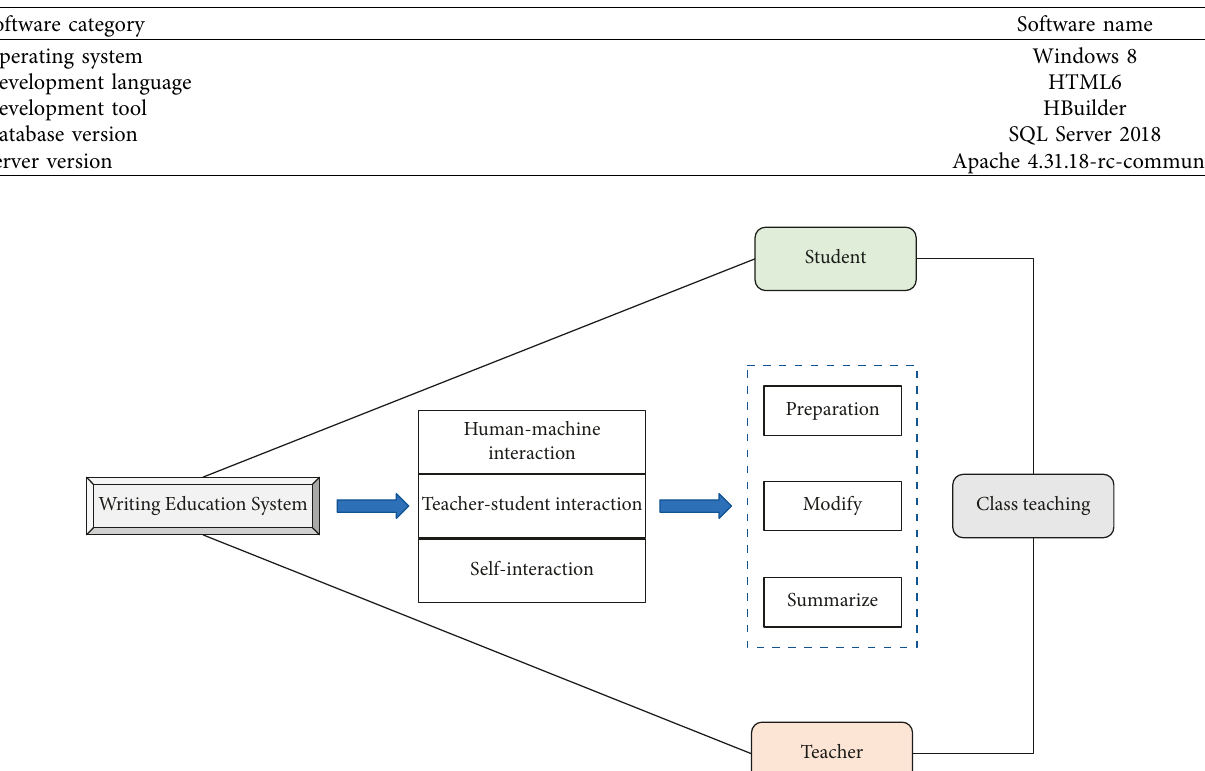
Figure 2: Whole teaching process following the application concept. Table 1: System development environment.